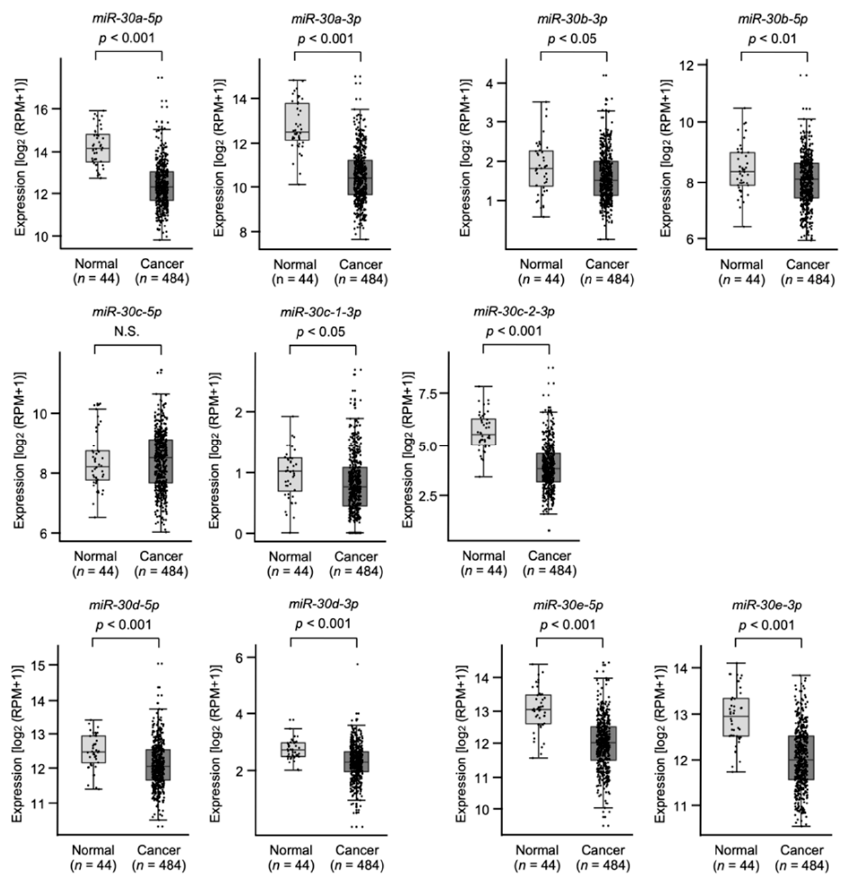
Figure 2. The expression level of the miR-30 family was analyzed using TCGA-HNSC database. A total of 484 HNSCC tissues and 44 normal epithelial tissues were evaluated (N.S.: not